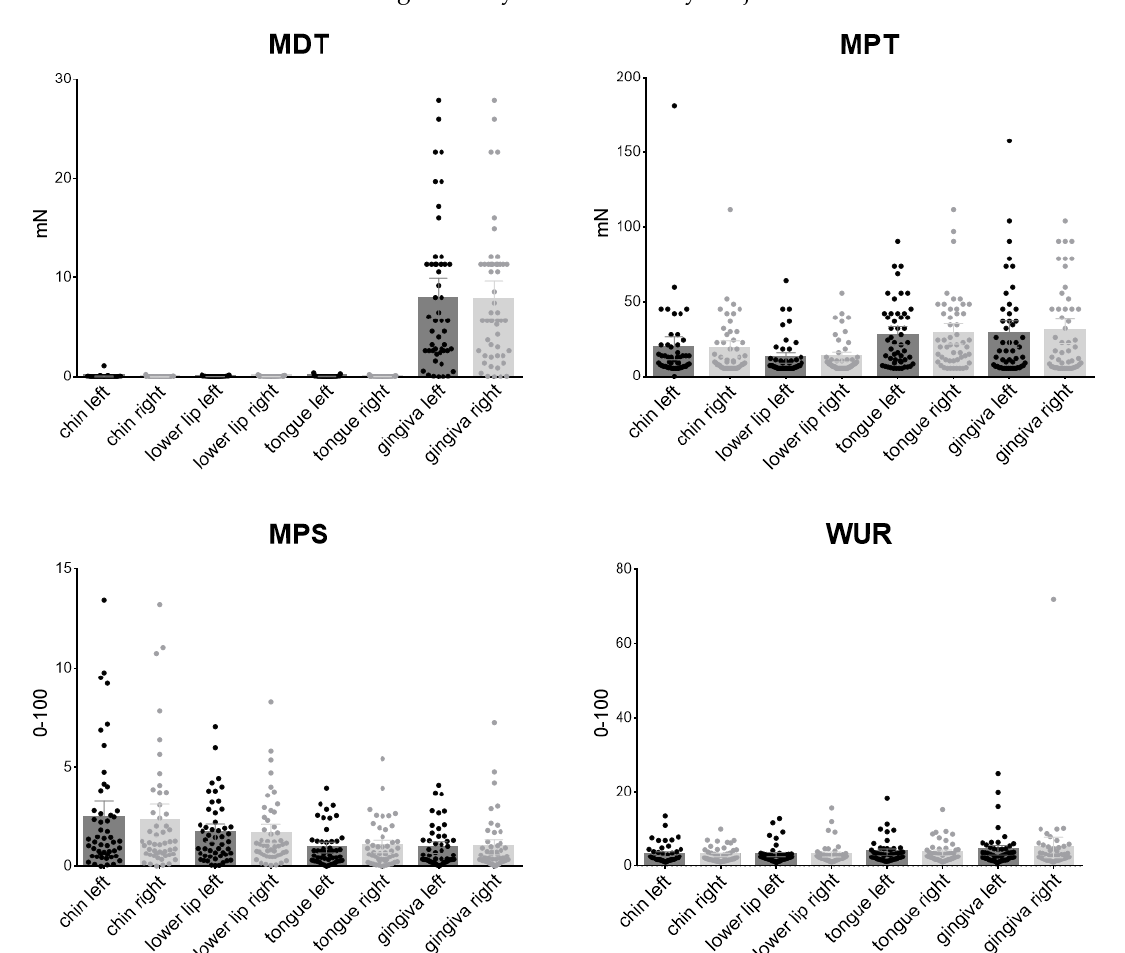
Figure 3. Mechanical thresholds (detection and pain raw values) for extraoral (chin, lower lip) and intraoral (tongue tip, gingiva) left and right areas. (MDT = Mechanical Detection Threshold, MPS = Mechanical Pain Sensitivity, MPT = Mechanical Pain Threshold, WUR = Wind Up Ration).